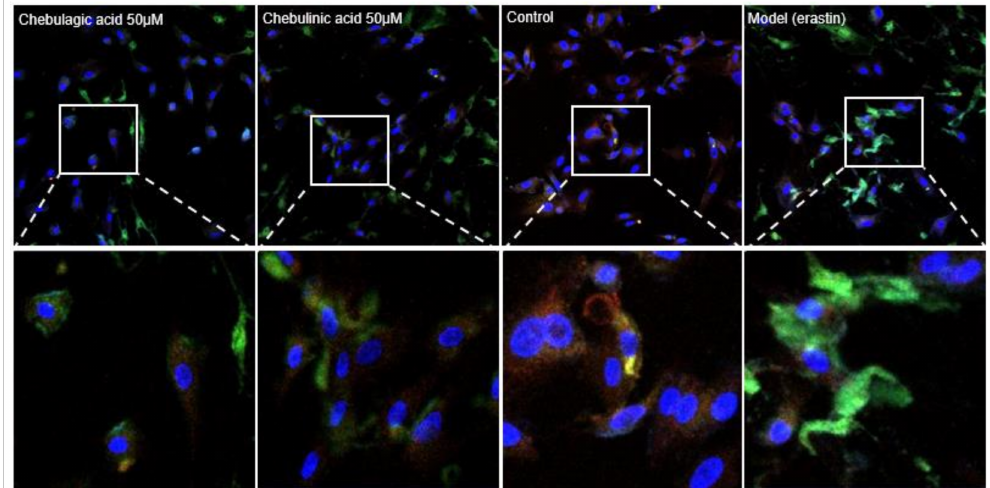
Figure 2. Microscopy images of fluorescent staining. Chebulagic acid 50 µ M group, bmMSCs treated with erastin + 50 µ M chebulagic acid; chebulinic acid 50 µ M group, bmMSCs treated with erastin + 50 µ M chebulinic acid; control group, bmMSCs without erastin treatment; model group, erastin-treated bmMSCs. The green fluorescence resulted from H2DCFDA dye and indicates the reactive oxygen species (ROS) accumulation; the blue fluorescence resulted from DAPI (4’,6-diamidino- 2-phenylindole) dye and indicates the cell nuclei; the red–blue fluorescence resulted from BBcell ProbeTM dye and indicates the mitochondria.